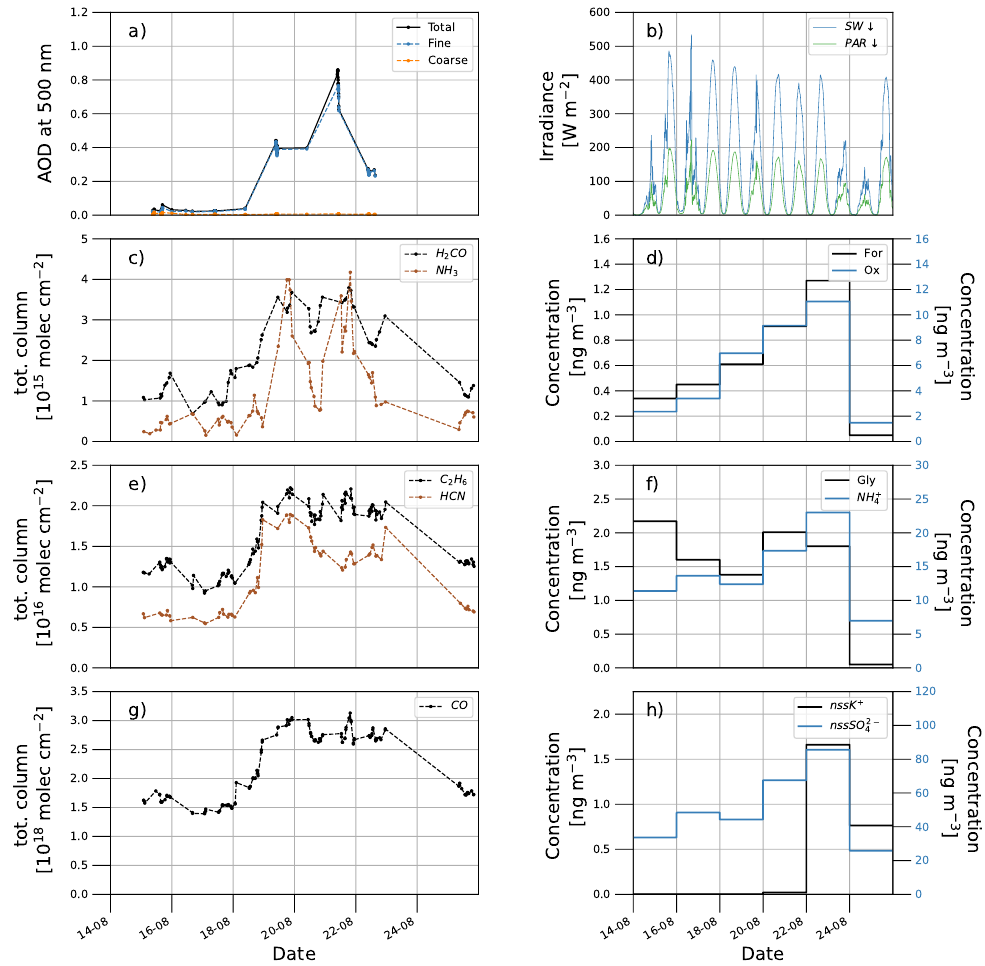
Figure 2. Time series of chemical species and physical properties measured at the THAAO during August 2017. ( a ) Total, fine, and coarse AOD data (unitless) are obtained from AERONET Version 3 dataset at 500 nm. ( b ) SW ↓ and PAR ↓ are obtained from the pyranometer and quantum sensor, respectively. ( c , e , g ) H 2 CO, NH 3 , C 2 H 6 , HCN, and CO concentrations are obtained from FTIR measurements; for further details, see Section 2. ( d , f , h ) The concentrations of nssSO 2 − oxalate (Ox), glycolate (Gly), and Formate (For) were measured in PM 10 samples (48-h resolution). The reduction in SW ↓ and PAR ↓ irradiances due to the aerosols can be estimated as the difference between 21 and 17 August measurements at the same SZA (78 ◦ ) (Figure S5). Differences in upward, downward, and net (downward minus upward) irradiances are also calculated. Results are summarized in Table